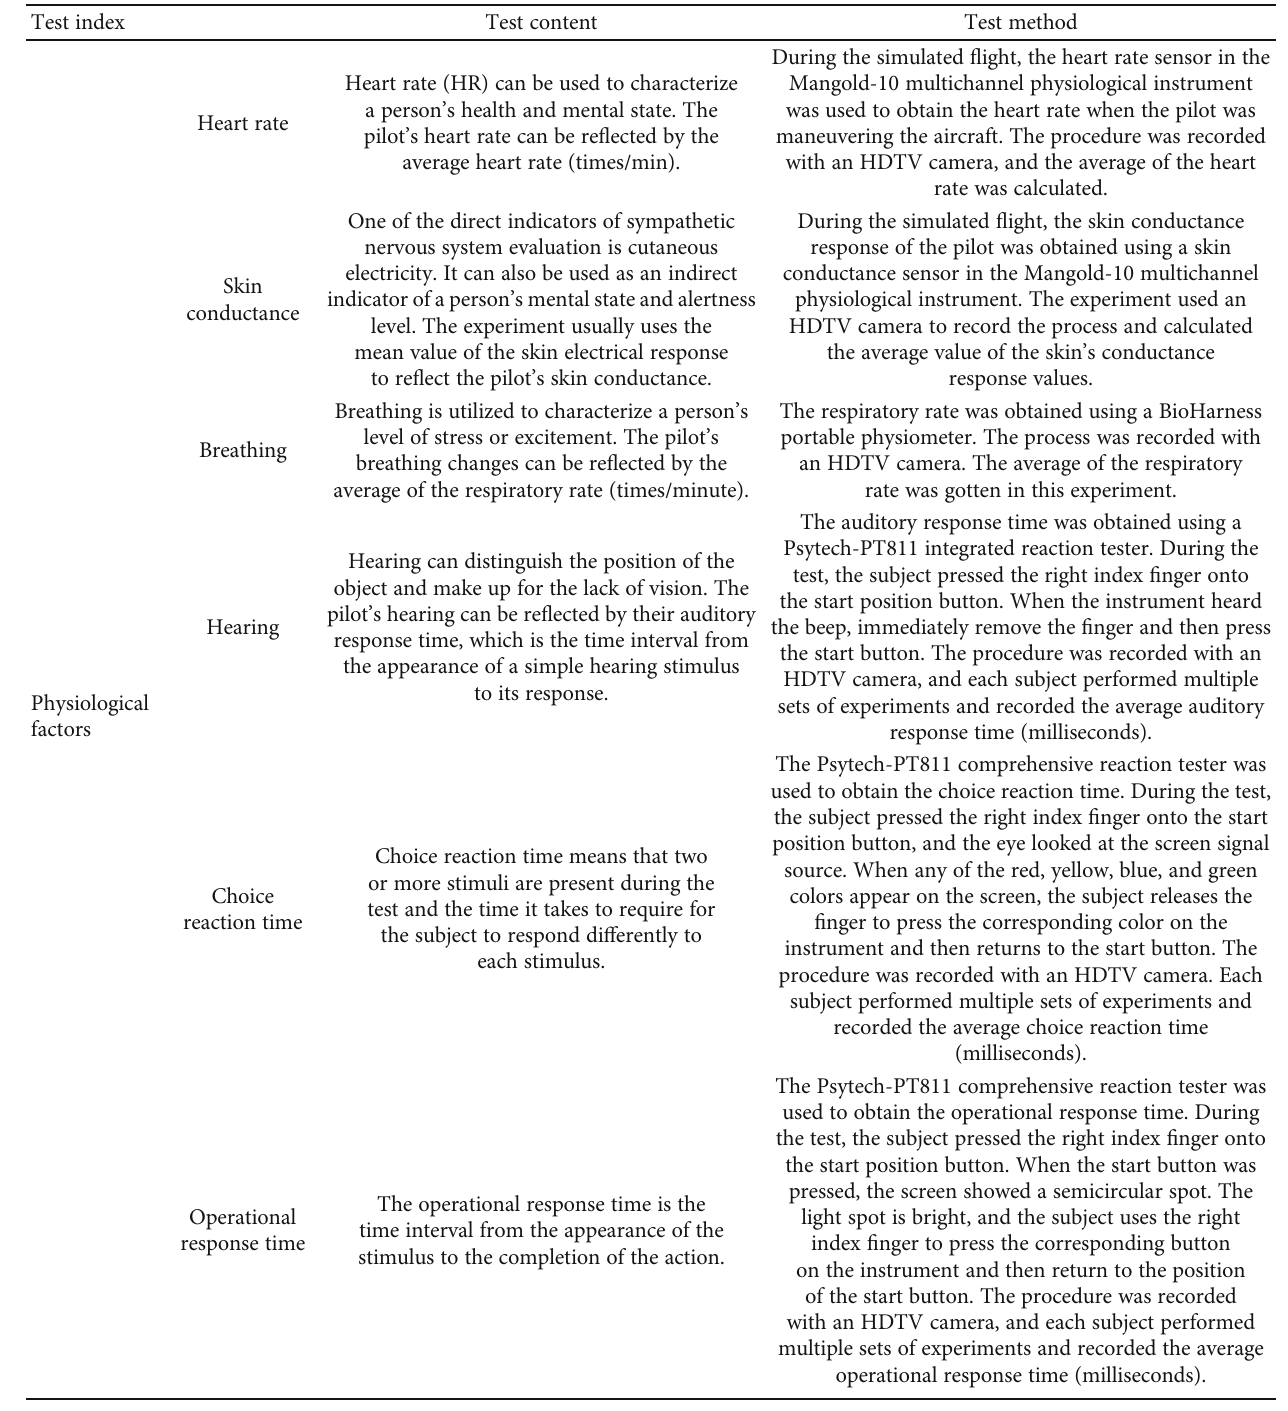
Table 2: Content and method for determining some physiological, psychological, and physical